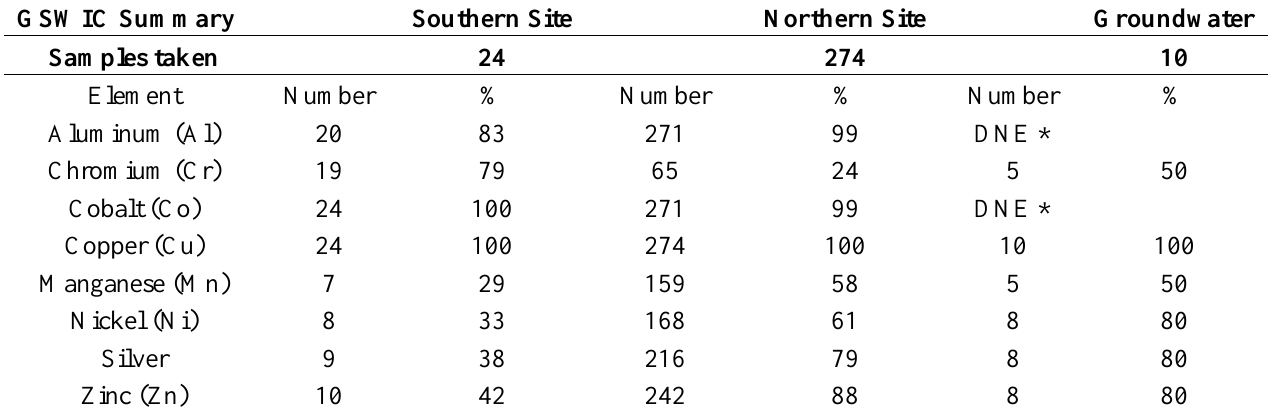
Table 3. Elements that exceed Michigan State Groundwater Surface Interface Criteria (GSWIC). Total stamp sand samples are listed in the first row entries, whereas the number of samples that exceeded the elemental GSWIC criteria and their percent are listed in the lower portion of the